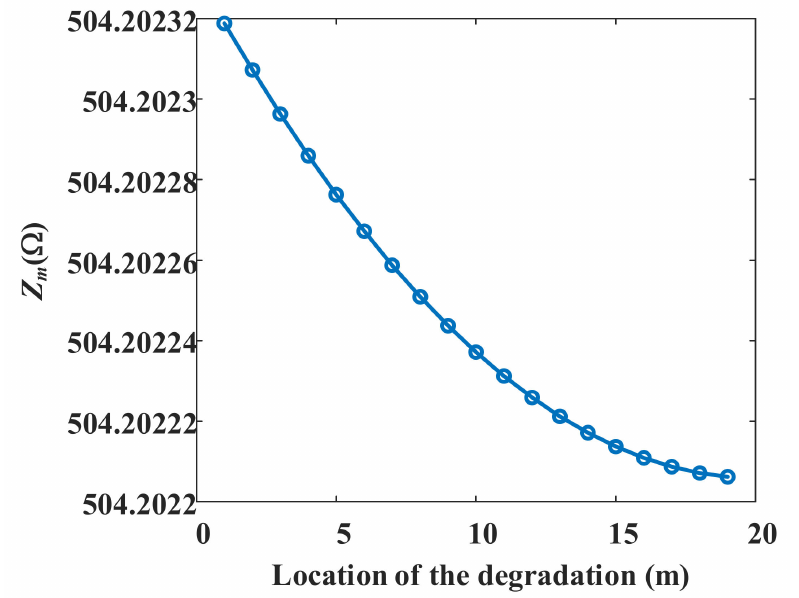
Figure 13. The monotonous relationship between the impedance magnitude at the characteristic frequency with respect to the position of the